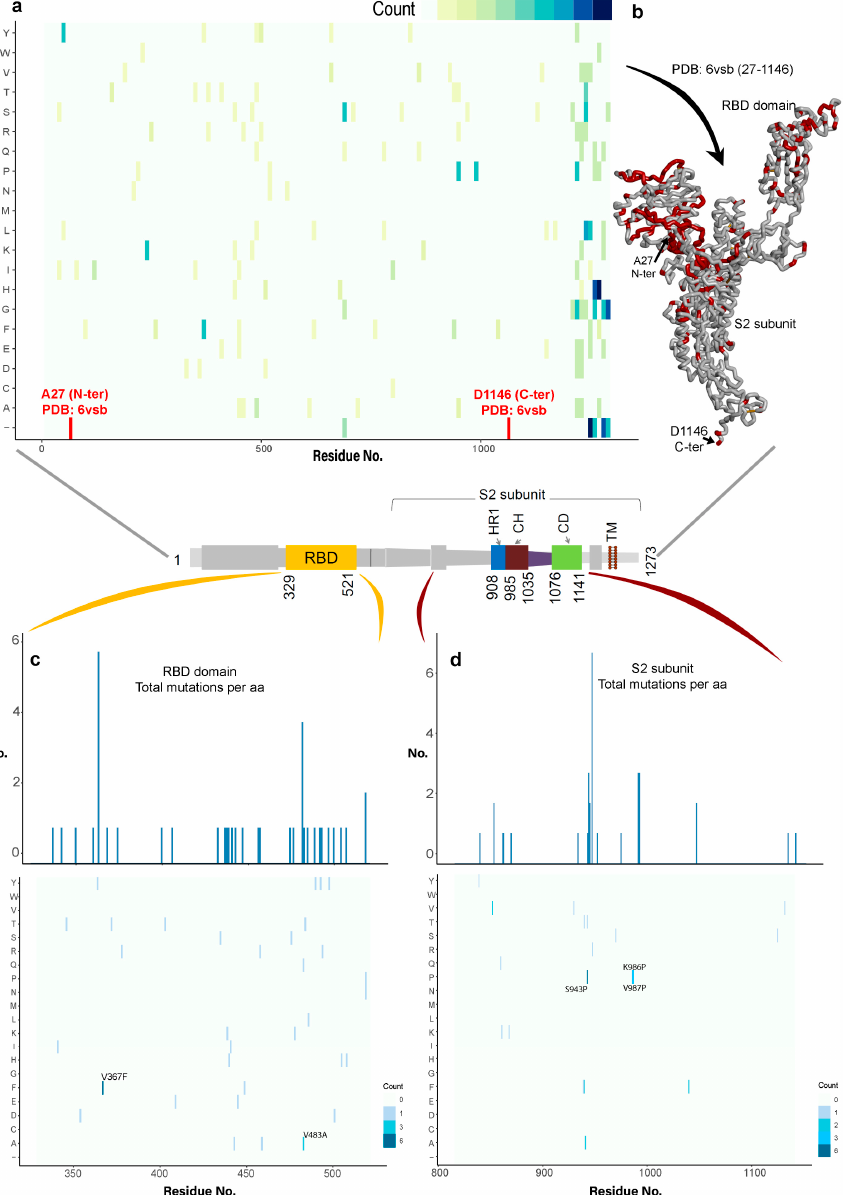
Figure 2. Variability in the SARS-CoV-2 spike protein. ( a ) The heat map contains the amino acid substitutions for each position in the spike protein compared to the consensus sequence (wild-type) from the alignment of 791 SARS-CoV-2 strains from the Global Initiative on Sharing All Influenza Data (GISAID) database [57]. ( b ) Represents the previous variations over the spike protein structure, marking in red color the spots of variability. ( c , d ) Analysis of the amino acid substitutions in the receptor binding domain (RBD) domain and in the S2 subunit (HR1, CH, and CD domains), including a bar plot with the total number of changes for each